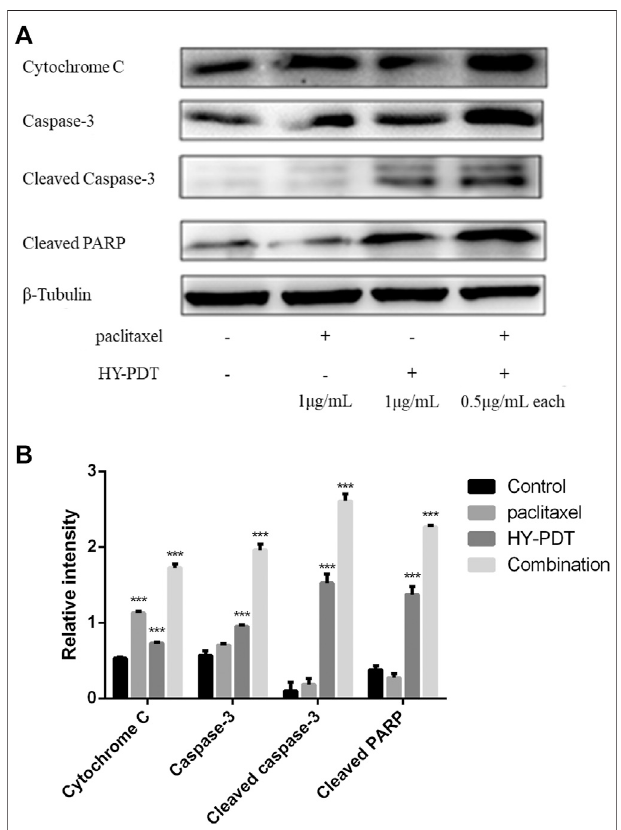
FIGURE 4 | Effect of paclitaxel and HY-PDT on the expression of apoptosis regulators. (A) The levels of cytochrome c, caspase-3, and PARP weremeasured bywesternblottinganalysisafterpaclitaxel(1 μ g/ml),HY-PDT (1 μ g/ml), and thecombined(0.5 μ g/ml each) treatment. CytochromeC, 15 kDa;caspase-3,32 kDa;cleavedcaspase-3,17,and19 kDa;andcleaved PARP, 89 kDa. The original western-blot images are in the Supplementary Figures . (B) ImageJ analysis of relative intensity, *** p < 0.001, compared to the control.